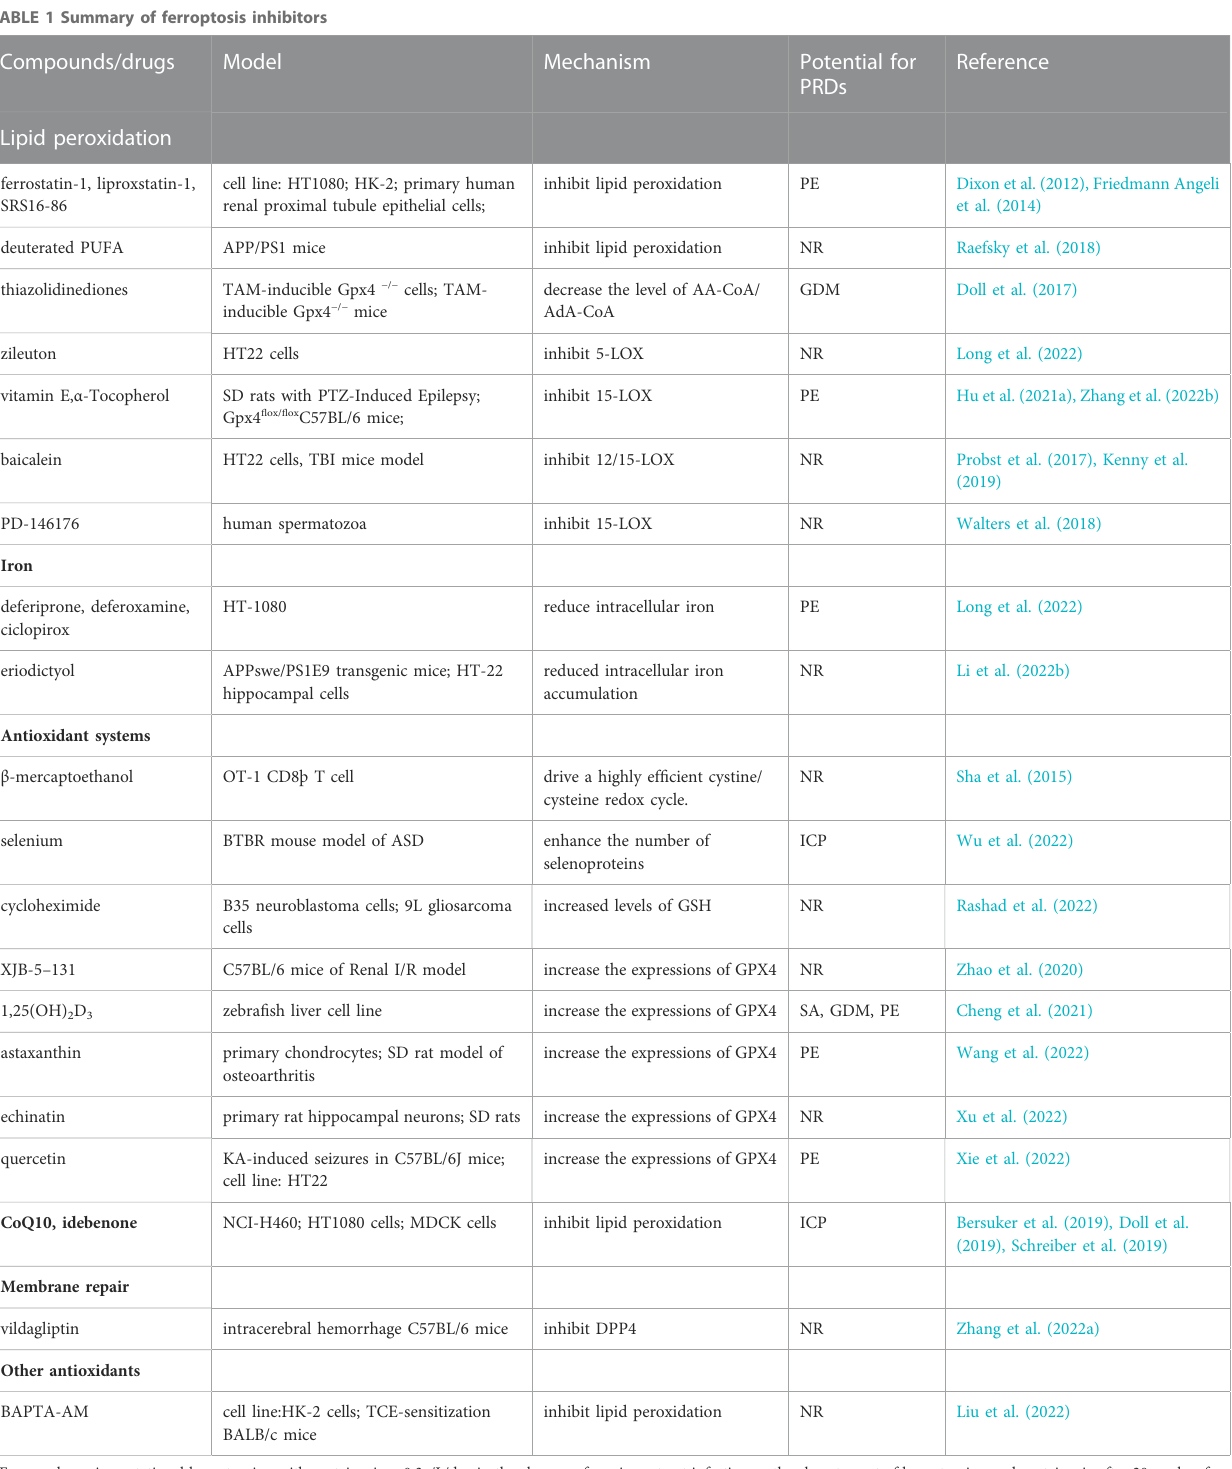
TABLE 1 Summary of ferroptosis